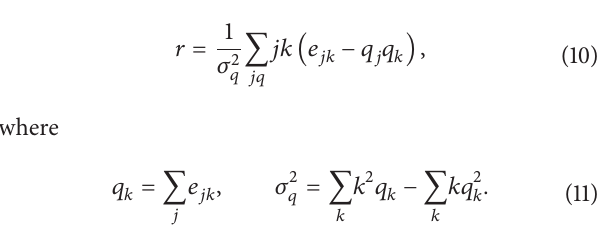
Figure 6: Betweenness